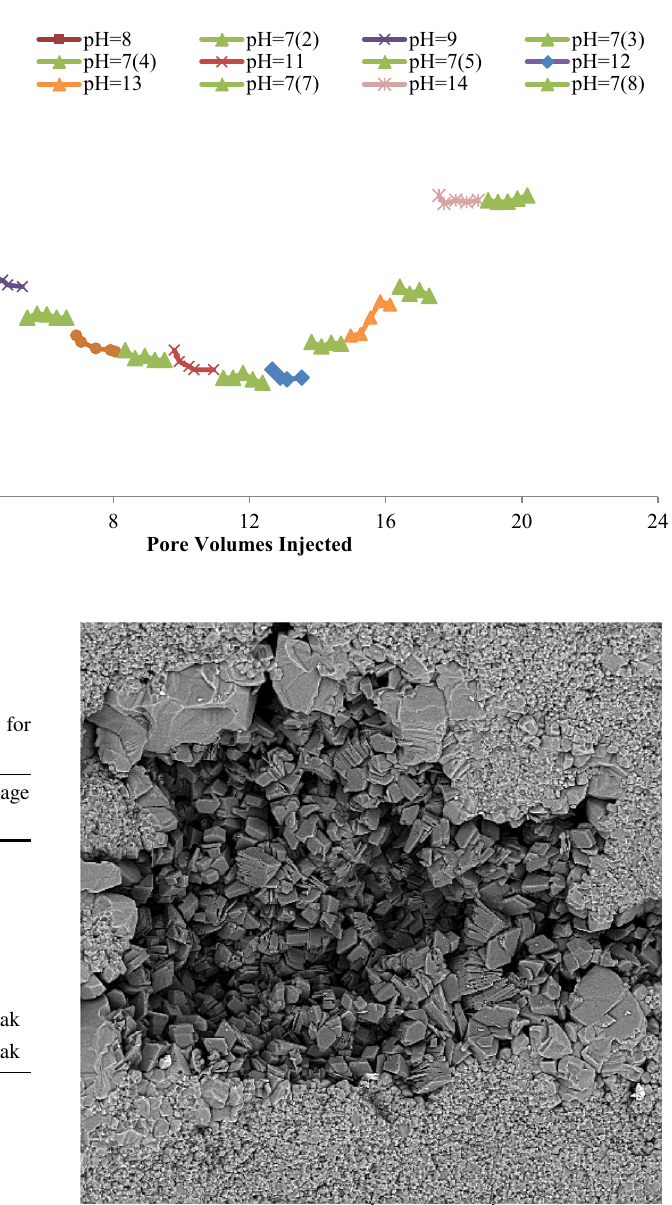
Fig. 11 SEM image of kaolinite flakes attached to pore walls for core